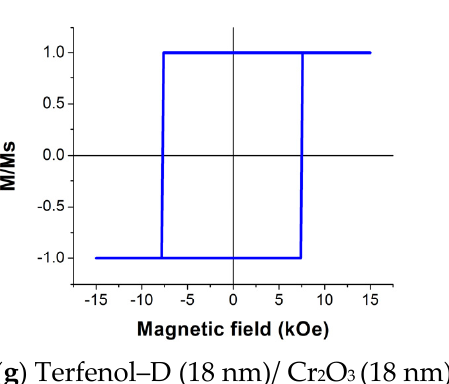
Figure 11. The hysteresis loops of 18 nm thick Terfenol–D coupling with Cr 2 O 3 at the Cr 2 O 3 thickness of ( a ) 0 nm, ( b ) 3 nm, ( c ) 6 nm, ( d ) 9 nm, ( e ) 12 nm, ( f ) 15 nm, and ( g ) 18 nm.